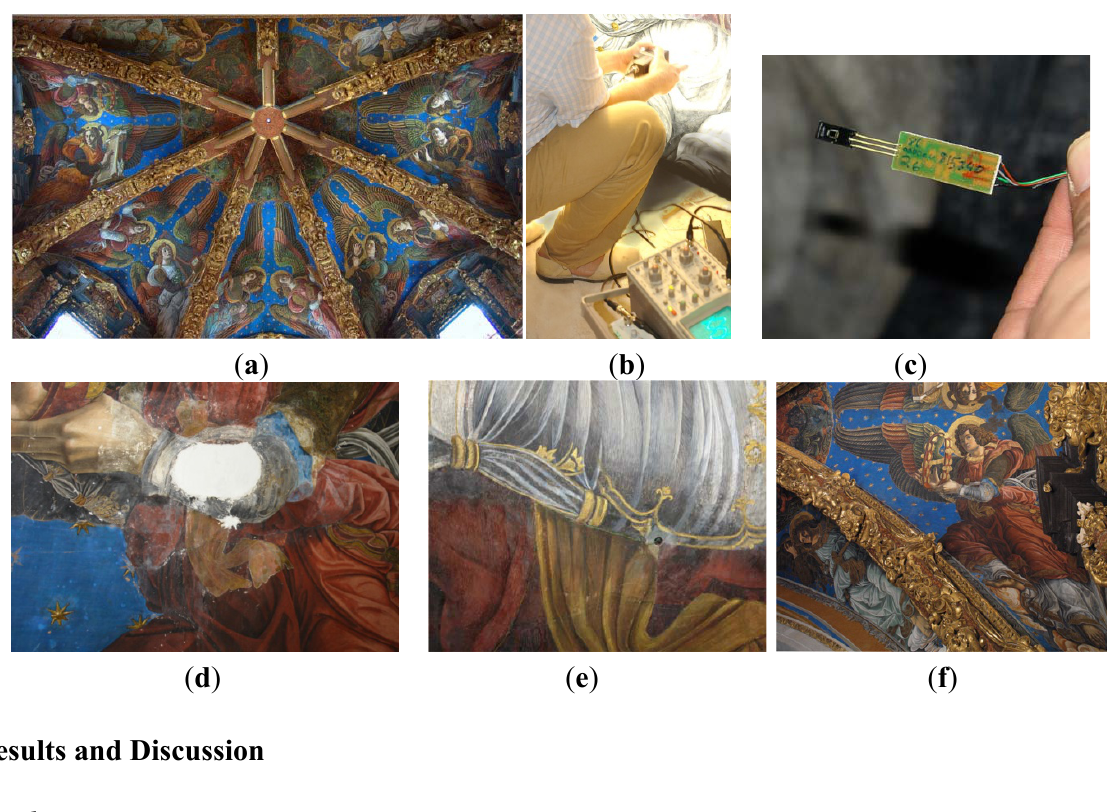
Figure 5. ( a ) Overview of the vault of the Valencia Cathedral; ( b ) Manual scan looking for the sensors insertion points in frescoes; ( c ) Humidity sensor detail; ( d ) Forearm detail of (f) before restoration; ( e ) In the center of the picture, a sensor is inserted by the ultrasound technique in (d); ( f ) Detail of the vault after the